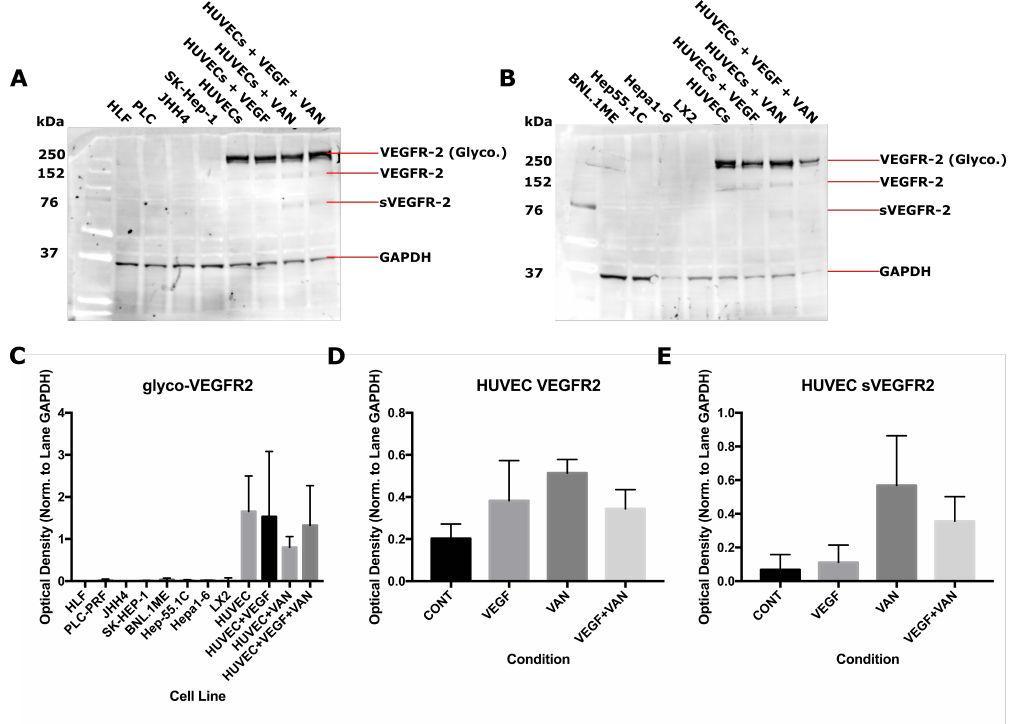
Figure 1. Expression status of vascular endothelial growth factor receptor-2 (VEGFR-2). VEGFR-2 expression was compared to Human Umbilical Vein Endothelial Cell (HUVEC) controls in ( A ) human and ( B ) murine cell lines. Cell extracts were labelled with VEGFR-2 antibody and Glyceraldehyde 3-phosphate dehydrogenase (GAPDH) antibody as a loading control. HUVEC cell lines were serum starved and treated with vandetanib for 24 h, then dosed with 50 ng/mL vascular endothelial growth factor (VEGF) for 20 min prior to fixation. Expression of glycosylated ( C ), native ( D ), and soluble vascular endothelial growth factor receptor-2 (VEGFR-2) ( E ) as measured by optical density is